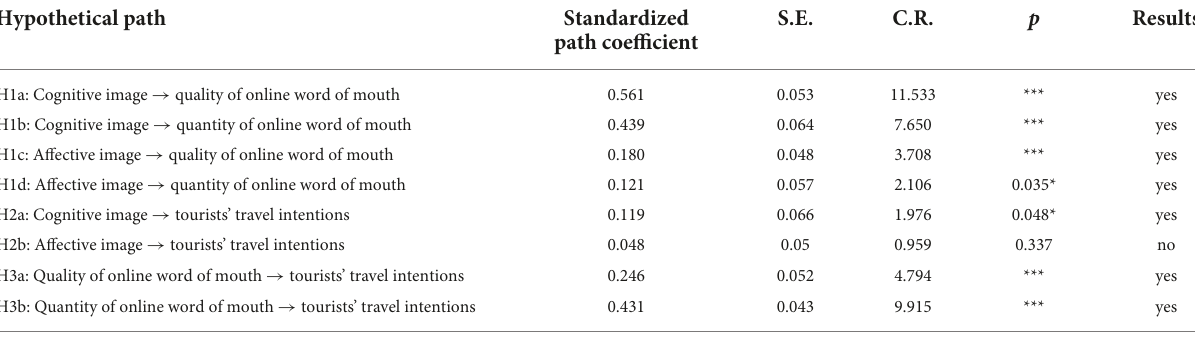
TABLE 5 Hypotheses testing results.